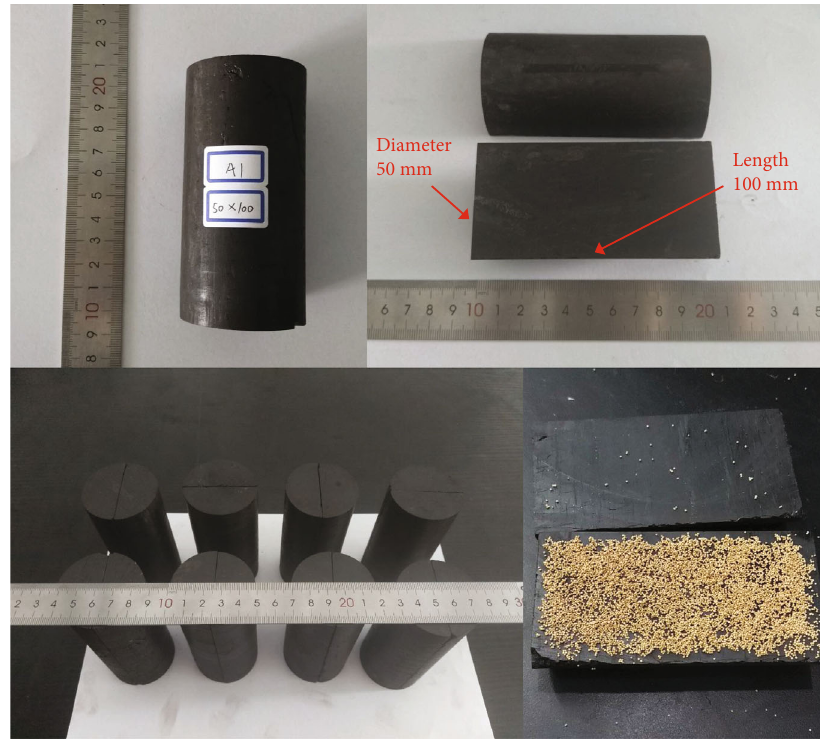
Figure 1: Pictures of coal samples used in the experiment.